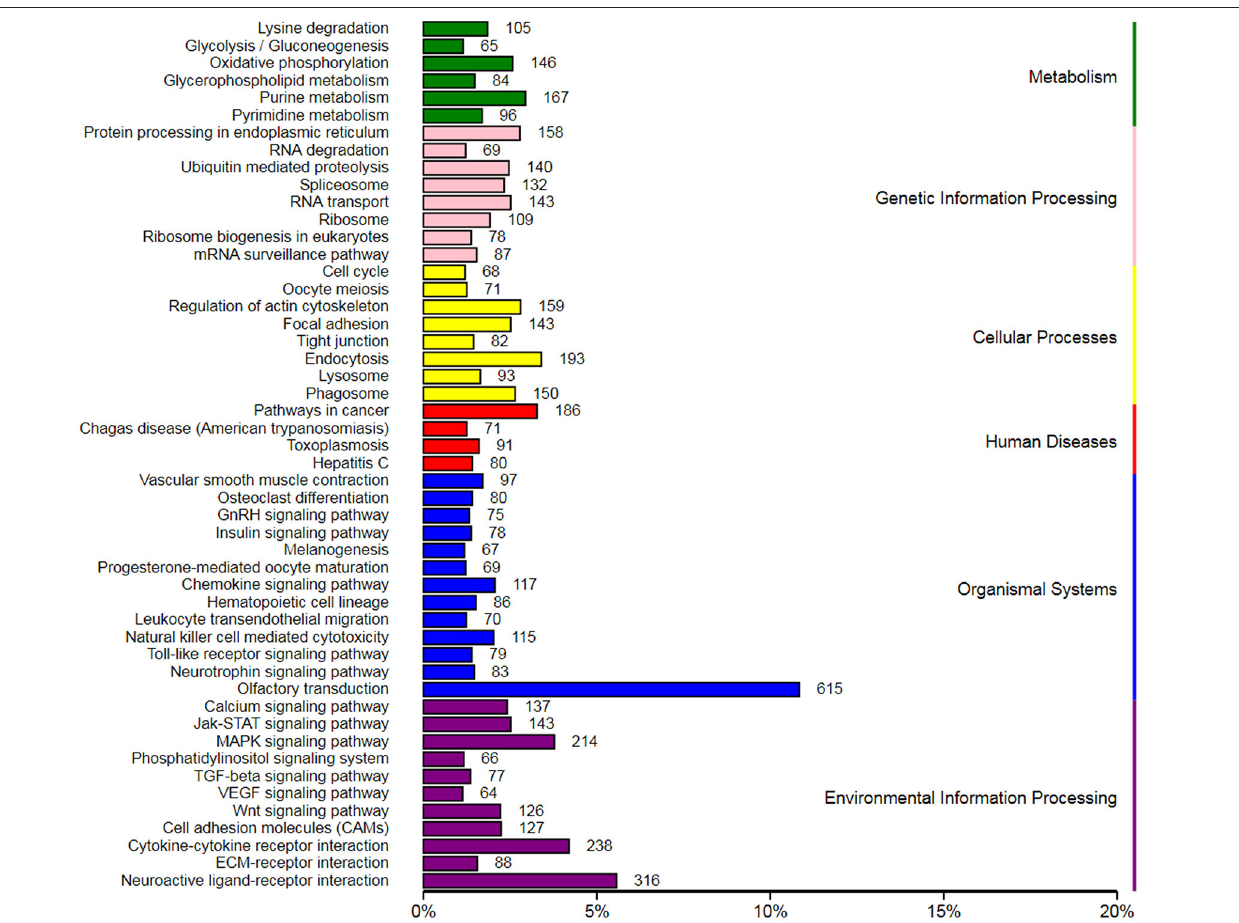
FIGURE 8 | Kyoto Encyclopedia of Genes and Genomes (KEGG) enrichment of target genes of differentially expressed miRNAs in the peripheral blood of dairy cow with S. aureus -type